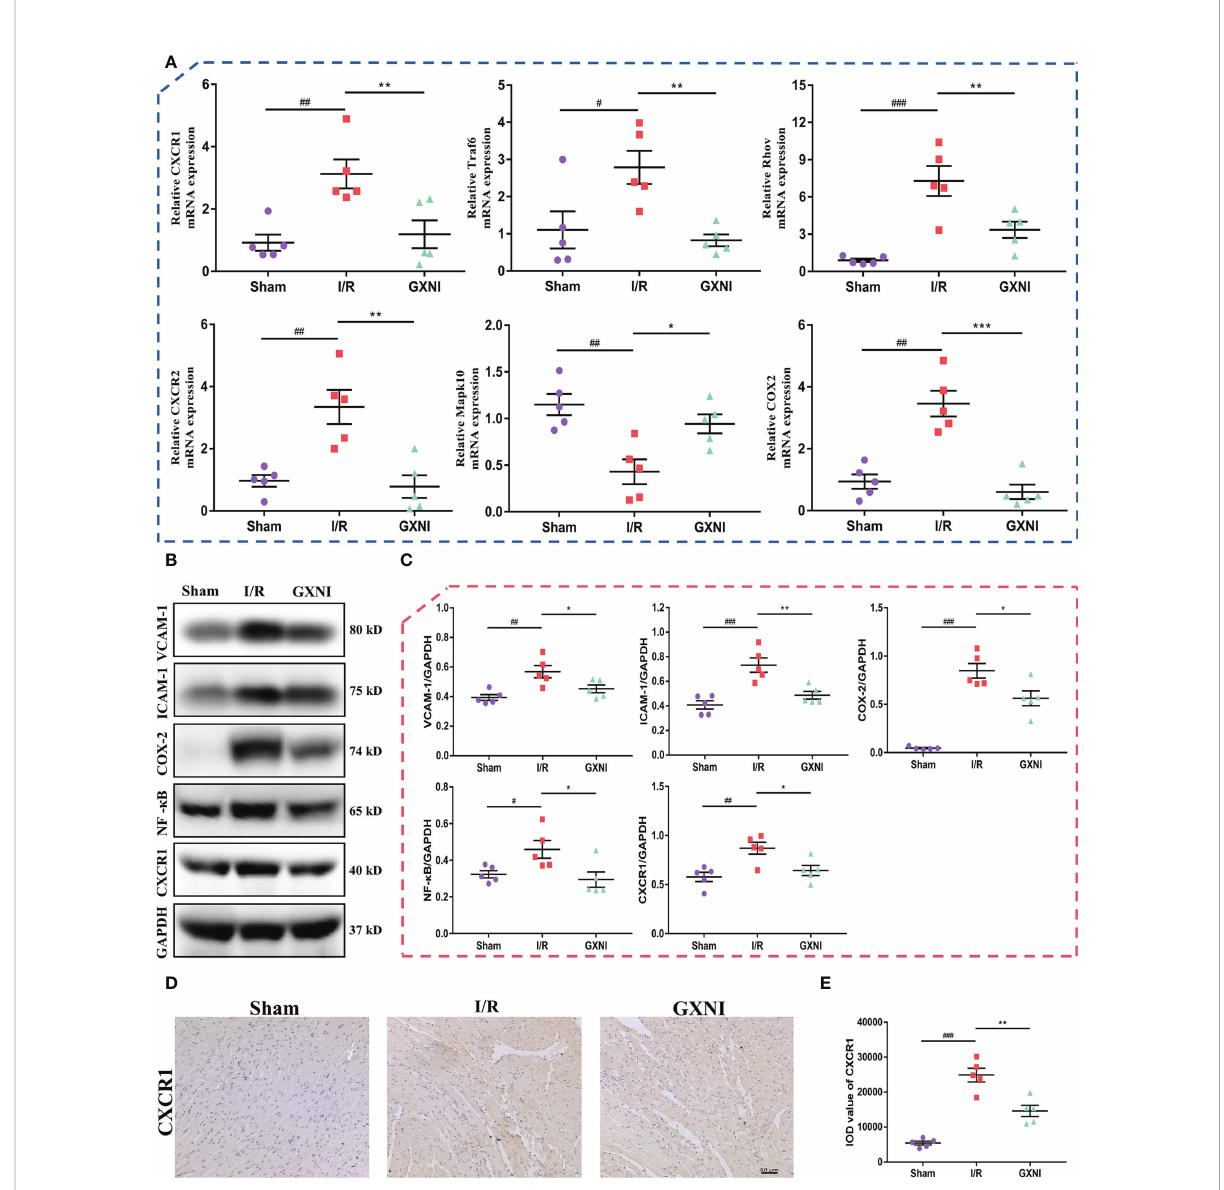
FIGURE 4 Veri fi cation of CXCR1-NF- k B-COX-2/ICAM-1/VCAM-1 pathway regulated by GXNI. (A) RT-PCR veri fi cation results of GXNI regulated genes in CXCR1-NF- k B-COX-2/ICAM-1/VCAM-1 pathway, including Cxcr1 , Cxcr2 , Traf6 , Mapk10 , Rhov and Cox2 . (B) Representative blots of CXCR1, NF- k B, COX-2, ICAM-1 and VCAM-1 in the sham, I/R, and GXNI (9 mL/kg) groups. (C) Quanti fi cation of expression levels of CXCR1, NF- k B, COX-2, ICAM-1 and VCAM-1 proteins. (D) Representative pictures of immunohistochemistry staining. (E) Quanti fi cation of CXCR1 expression levels in cardiac tissue sections. Values were expressed as mean ± SEM (n = 5). # P < 0.05, ## P < 0.01, ### P < 0.001 vs. sham group, * P < 0.05, ** P < 0.01, *** P < 0.001 vs. I/R